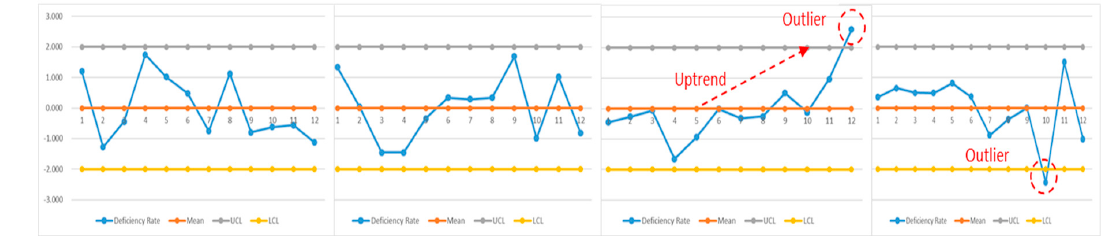
J. Mar. Sci. Eng. 2020 , 8 , x FOR PEER REVIEW Figure 12. The control chart for deficiency 08 (2015–2018). Figure 12. The control chart for deficiency 08 (2015–2018).